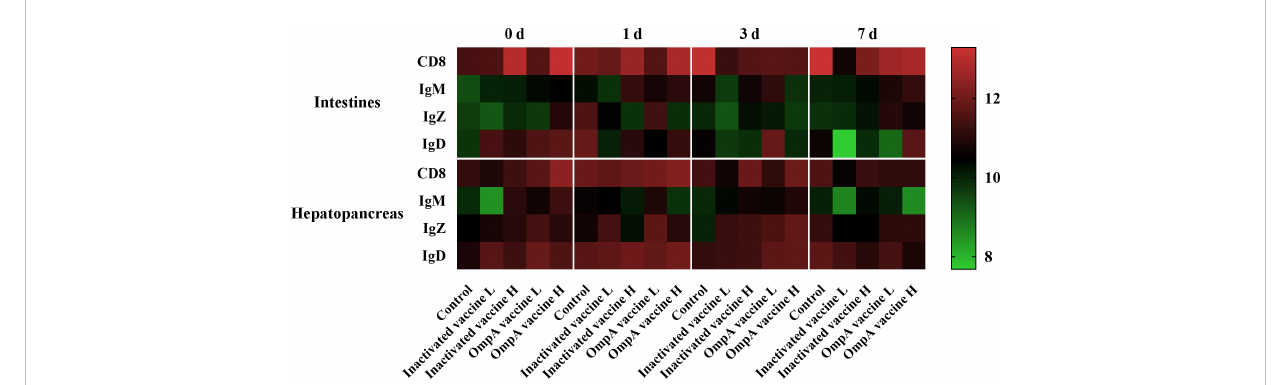
FIGURE 5 Heatmap illustrates results from IHC assay for the number of immune positive cells that affected by vaccination in the hepatopancreas and intestines at different time points post infection. Color value: log2 (fold